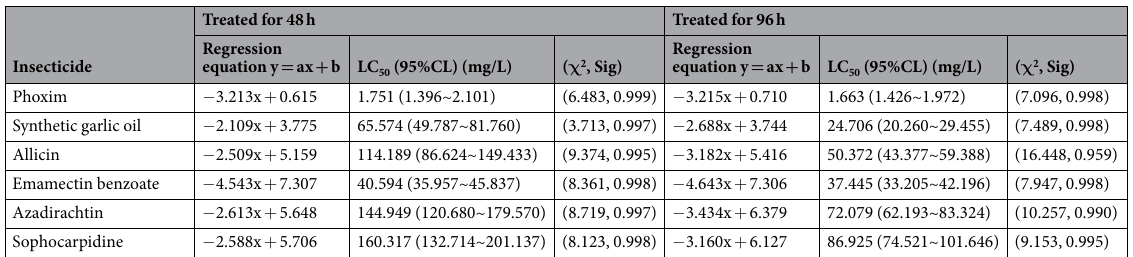
Table 4. Toxicity of synthetic garlic oil, diallyl disulphide and 4 insecticides against fourth instar of Bradysia odoriphaga . The survival rate was recorded after 48 h and 96 h for the rapid and chronic effect